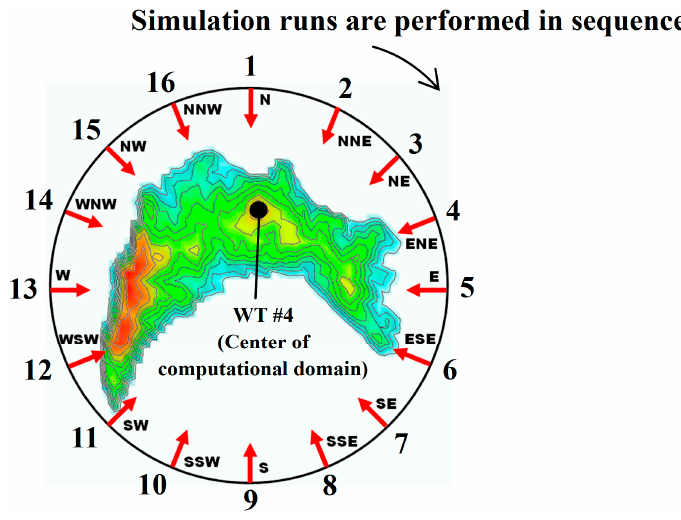
Figure 6. Conceptual outline of wind simulations for 16 wind directions for Noma Wind Park.